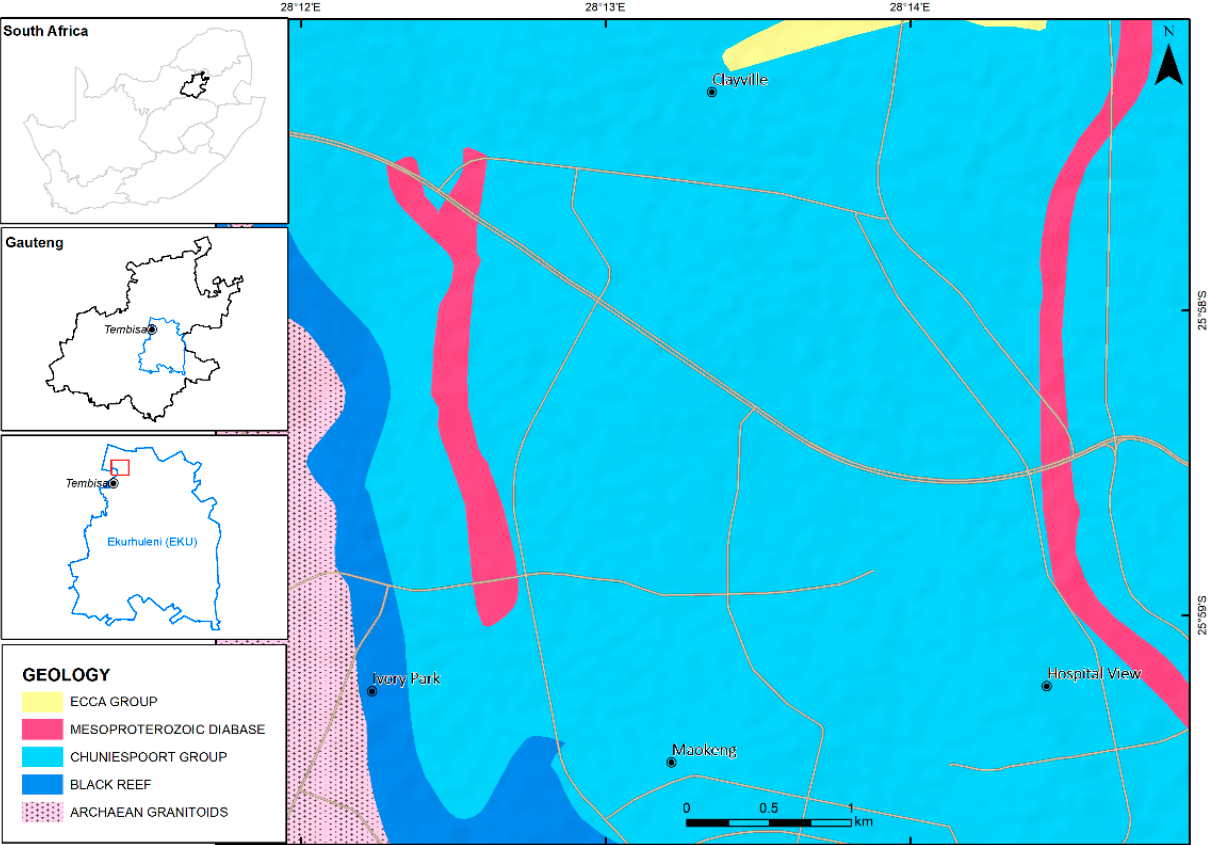
Figure 2. Geological map of the study area.